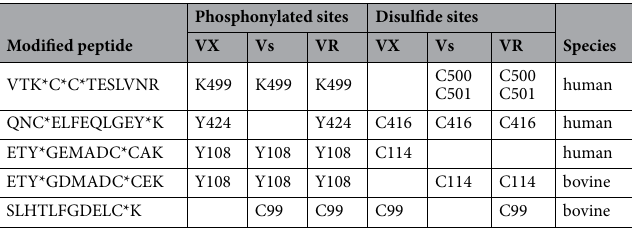
Table 5. Disulfide adducts in different species after V-type OPNAs